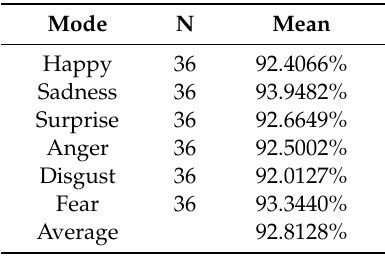
Table 10. The mean of the SS for all expressions.